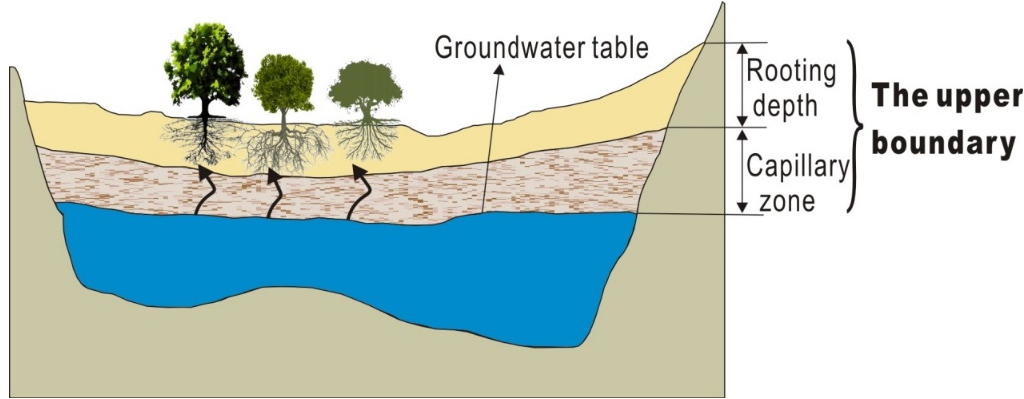
Figure 3. Diagram showing the conceptual upper groundwater boundary that is crucial to the stability of a present vegetation